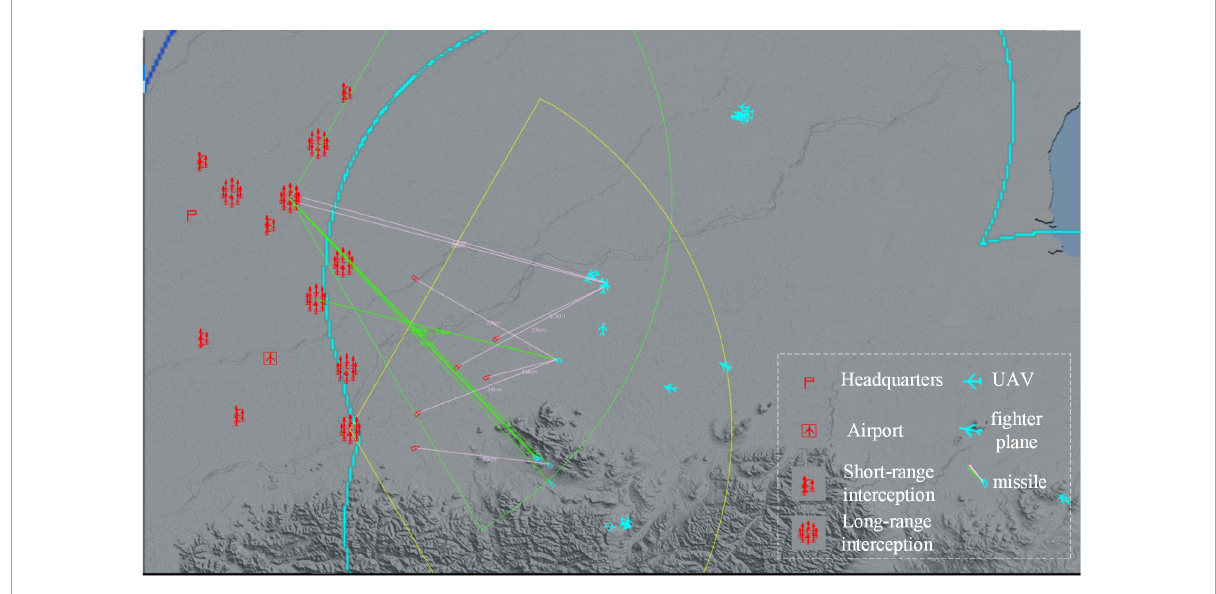
FIGURE5 Schematic diagram of an experimental